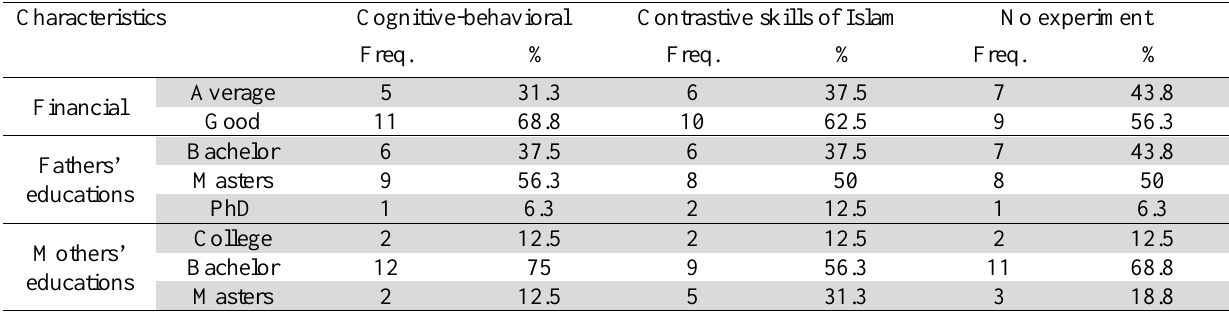
Personal characteristics of the participants